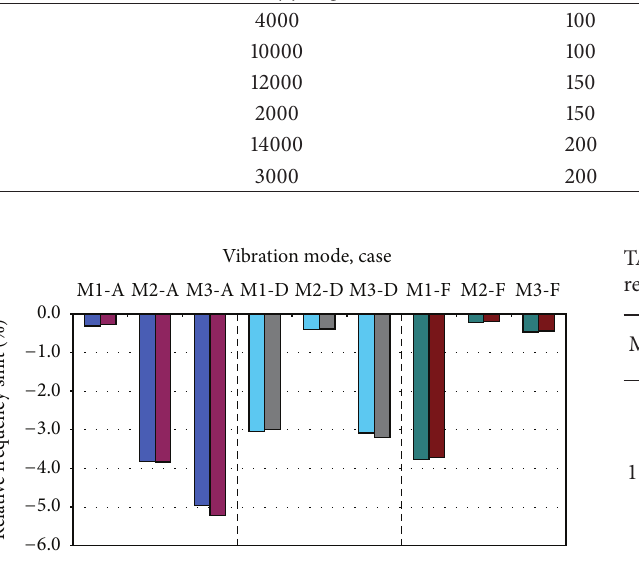
Figure 7: The relative frequency shifts analytically derived (left bars for each mode) and evaluated by FEA (bars positioned at right) for the mass increase on an extended region.